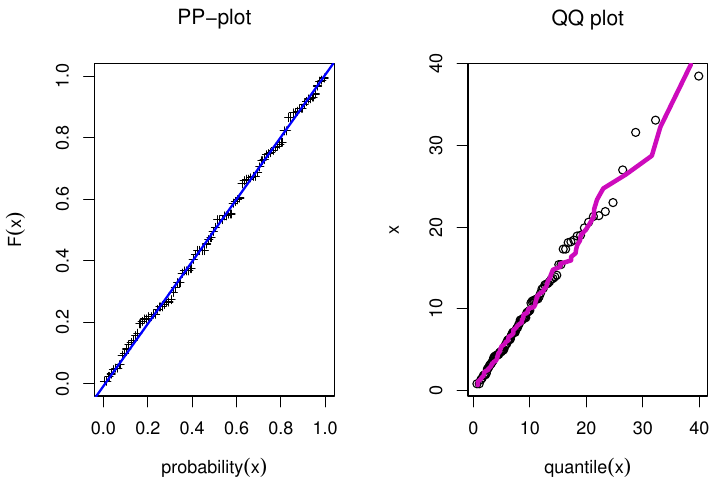
Figure 19. PP and QQ for TLMW model for waiting